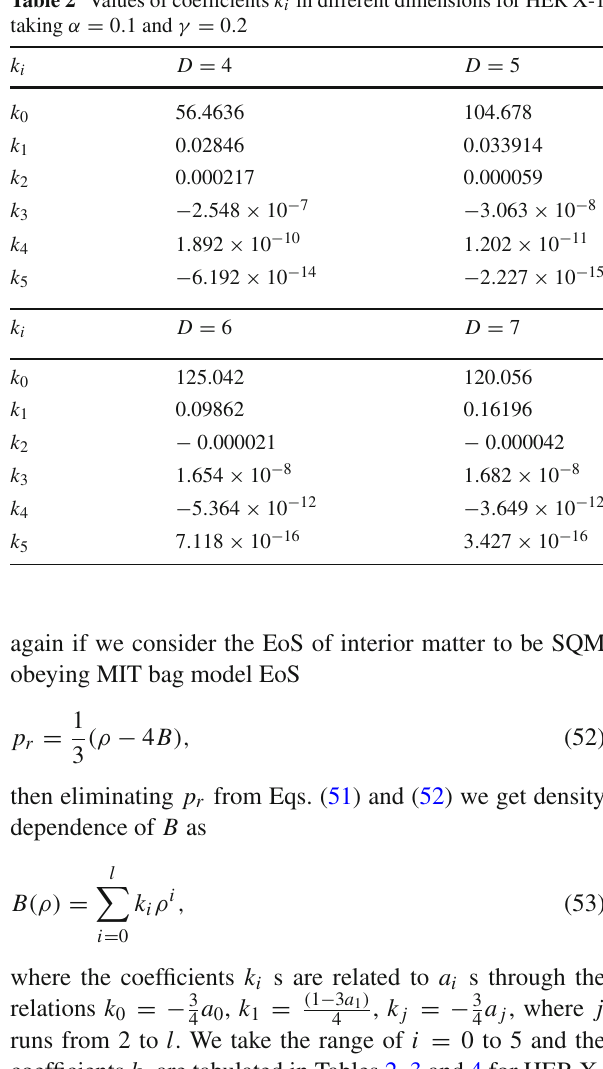
Fig. 15 Radialvariationof ( n − 1 ) ˜ ρ + ˜ p r + n ˜ p t + ( n − 1 ) E 2 fordifferent compact objects as indicated in the figure. Here plots with solid, dashed and dotted lines correspond to D = 4 , 5 and 6 respectively. To obtain the plots we choose (i) α = 0 . 4, γ = 0 . 45 when D = 4; α = 0 . 3, γ = 0 . 25 when D = 5 and α = 0 . 25, γ = 0 . 2 when D = 6 for HER X-1, (ii) α = 0 . 4, γ = 0 . 5 when D = 4; α = 0 . 3, γ = 0 . 25 when D = 5 and α = 0 . 2, γ = 0 . 15 when D = 6 for PSR J1614-2230, (iii) α = 0 . 4, γ = 0 . 5 when D = 4; α = 0 . 3, γ = 0 . 2 when D = 5 and α = 0 . 2, γ = 0 . 25 when D = 6 for EXO1745-248